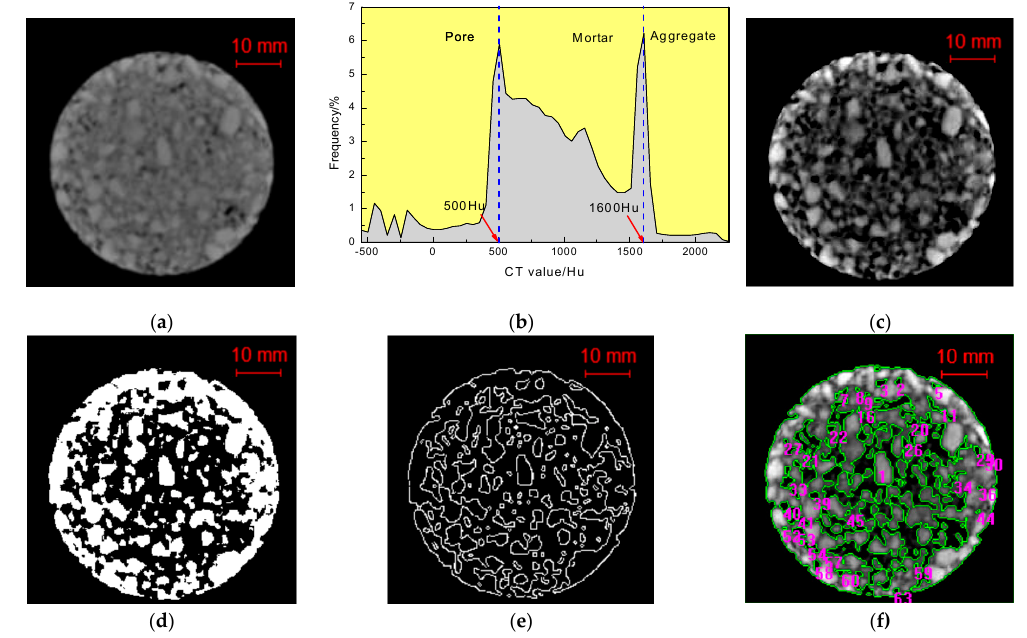
Figure 4. Digital image processing technology for the crack extraction procedure. ( a ) CT gray image, ( b ) CT number distribution, ( c ) Enhanced image, ( d ) Binary image, ( e ) Skeleton on binary image, ( f ) “AOI” selection.